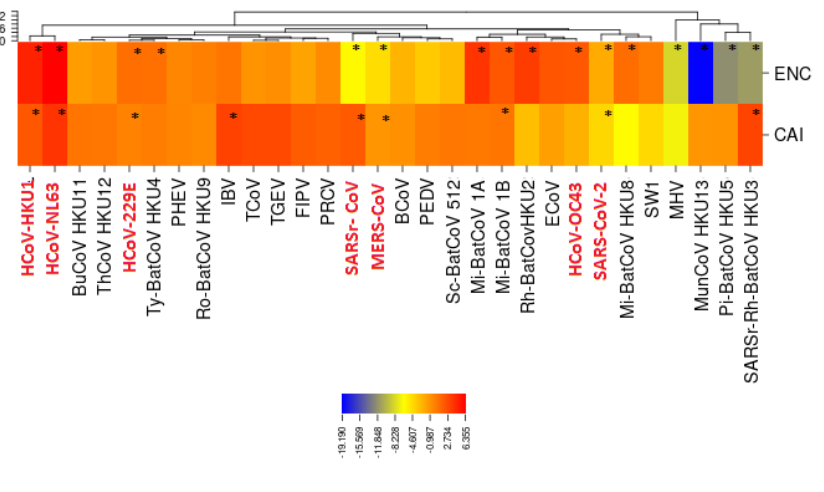
Figure 2. Z-score values. Z-score is calculated for two codon bias indeces: effective number of codons (ENC) and the competition adaptation index (CAI). CAI values are calculated by considering the hosts specified in Table 3 by Woo et al. [4]. Regarding SARS-CoV-2, we considered a human host. In red, we show the human coronaviruses. Several coronaviruses have a codon usage preference values higher than the average value of the family (|Z-score| > 3). The statistically significant differences are marked with asterisks. In particular, SARS-CoV-2 genes have average values of CAI and ENC that are higher than the average of all coronaviruses. (*): |Z-score| > 3.